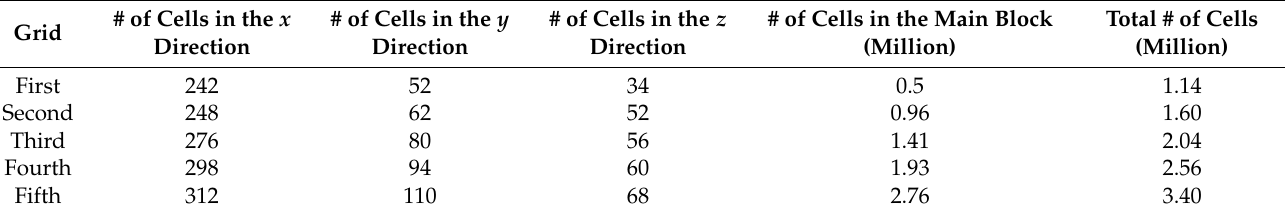
Figure 4. Result of mesh sensitivity test using the LES. Table 4. Specifications of grid arrangements for grid sensitivity